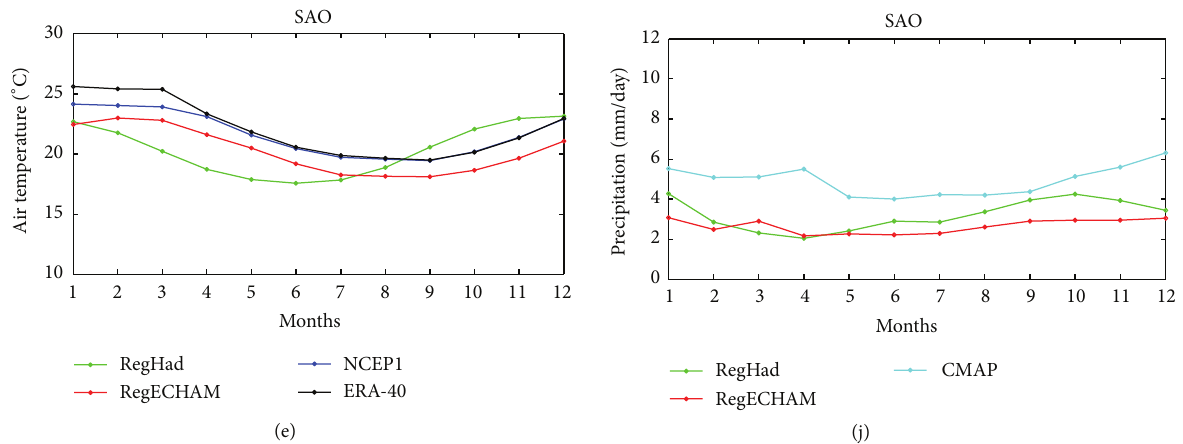
Figure 3: Annual cycle of air temperature ( ∘ C; left) and precipitation (mm day −1 ; right), from 1960 to 1990 (except CMAP: 1979–1990), in the five subdomains of South America shown in Figure 1: AMZ, SAM, SE, SO, and SAO. In the panels the green line represents the RegHad, the red line RegECHAM, the blue line NCEP, the black line ERA-40, the yellow line CRU, the pink line University of Delaware, and the cyan line